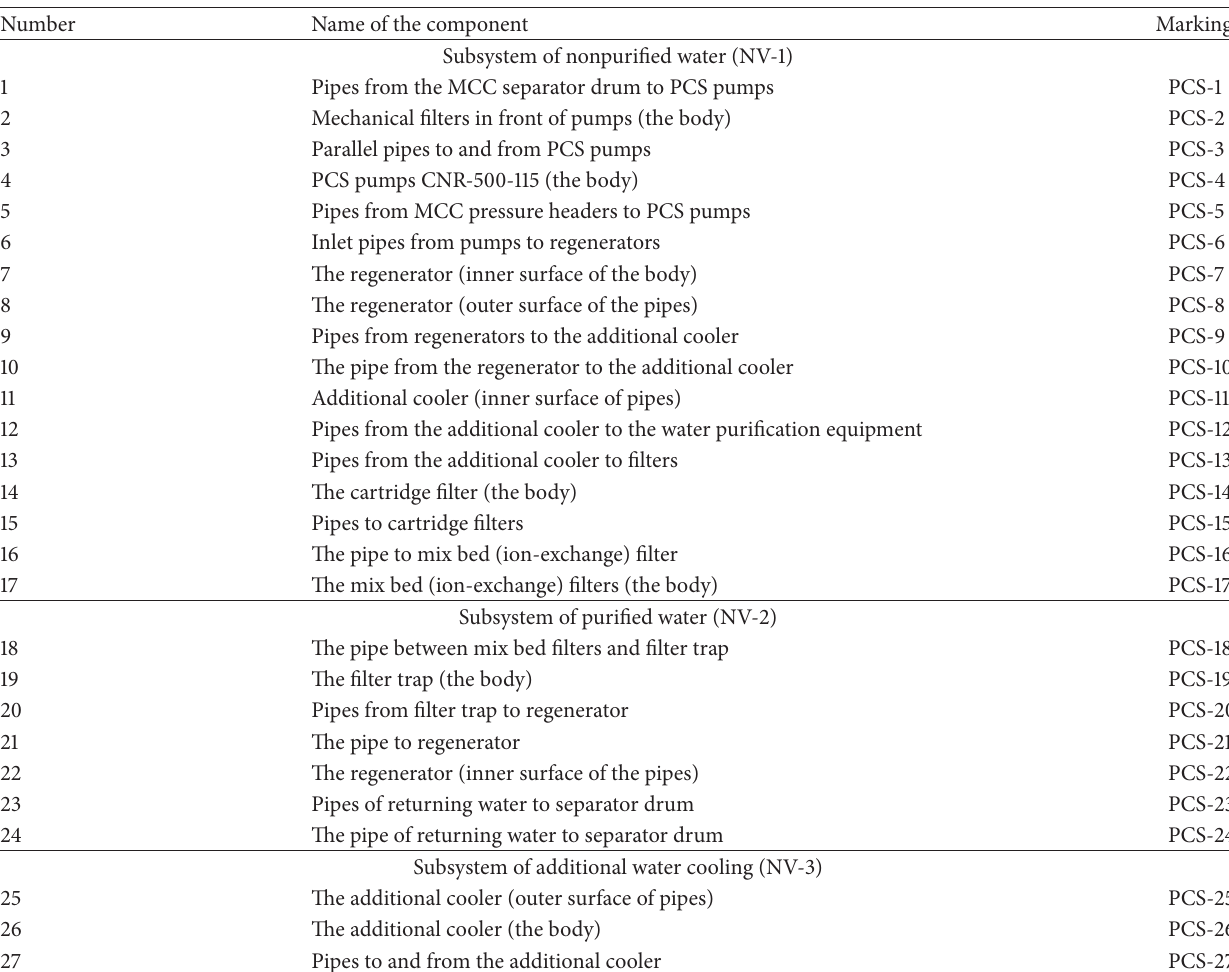
Table 1: Main PCS